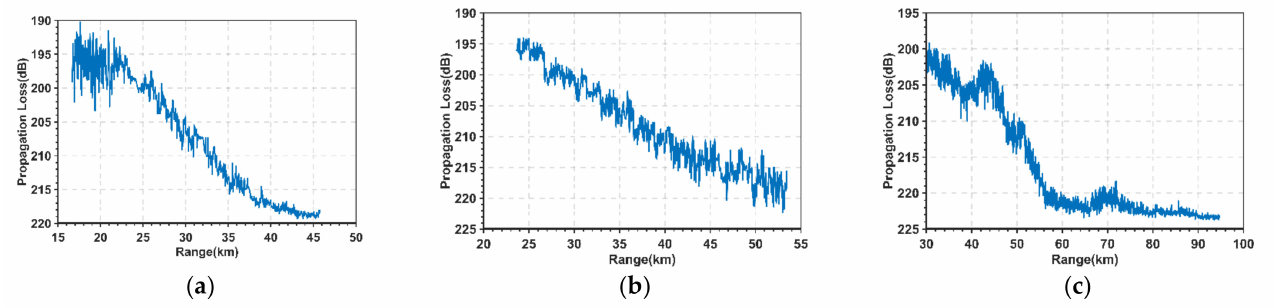
Figure 4. Three sets of PL sequences measured in the over − the − horizon propagation experiment: ( a ) first set; ( b ) second set; ( c ) third